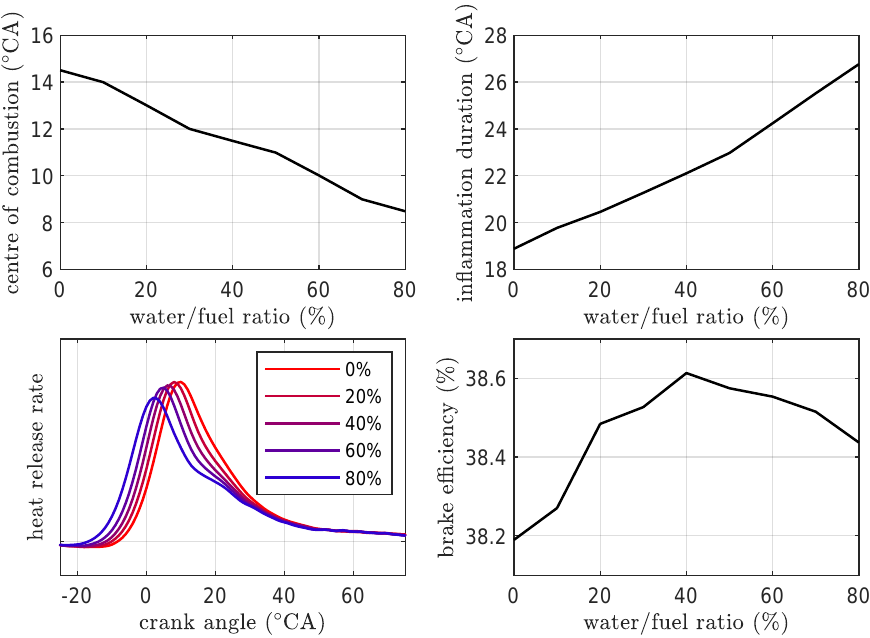
Figure 9. Effects of water injection on the combustion at an engine speed of 3000 rpm and a brake torque of 300 Nm. The bottom left plot shows the heat release rates for different water/fuel mass